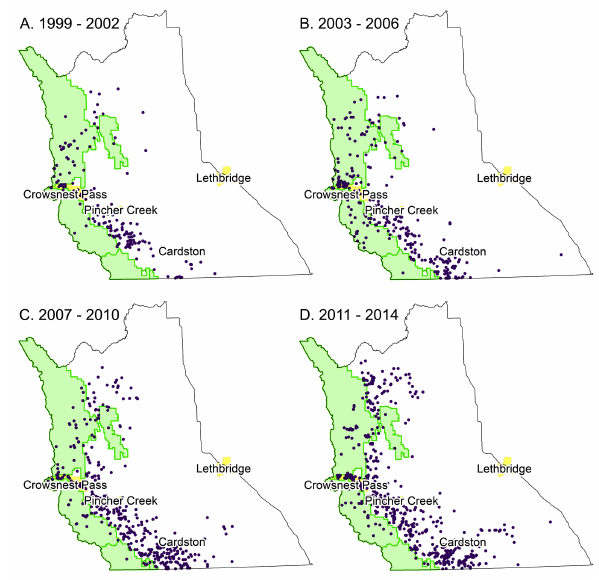
Fig. 4 . Primary attractants for (A) black bear, Ursus americanus (n = 816) and (B) grizzly bear, Ursus arctos incidents (n = 420) in occurrence records in southwestern Alberta, Canada 1999– 2014.